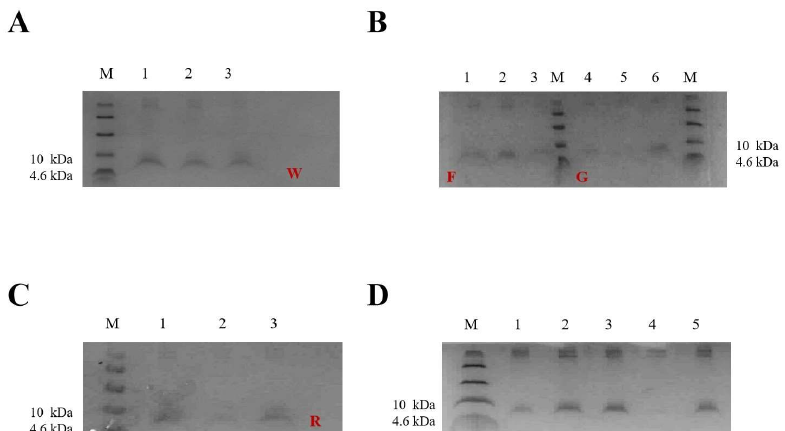
Figure 3. Tricine SDS–PAGE analysis of XNZ fermentation supernatants in 250 mL and 1 L shake flask levels. ( A ) Transformants of WNZ in 250 mL flask level. M, low-range protein ladder; Lanes 1 and 2, transformants of W25, W28; Lane 3, transformant of NZ2114, respectively. ( B ) Transformants of F/GNZ in 250 mL flask level. M, low-range protein ladder; Lanes 1 and 2, transformants of F34 and F39; Lanes 5 and 6, transformants of G1 and G12; Lanes 3 and 4, transformant of NZ2114. ( C ) Transformants of RNZ in 250 mL flask level. M, low-range protein ladder; Lanes 1 and 2, transformants of R27 and R33; Lane 3, transformant of NZ2114. ( D ) Transformants of W/R/G/FNZ in 1 L flask level. M, low-range protein ladder; Lane 1, transformant of NZ2114. Lanes 2 to 5 are the transformants W25, R33, G1, and F39,